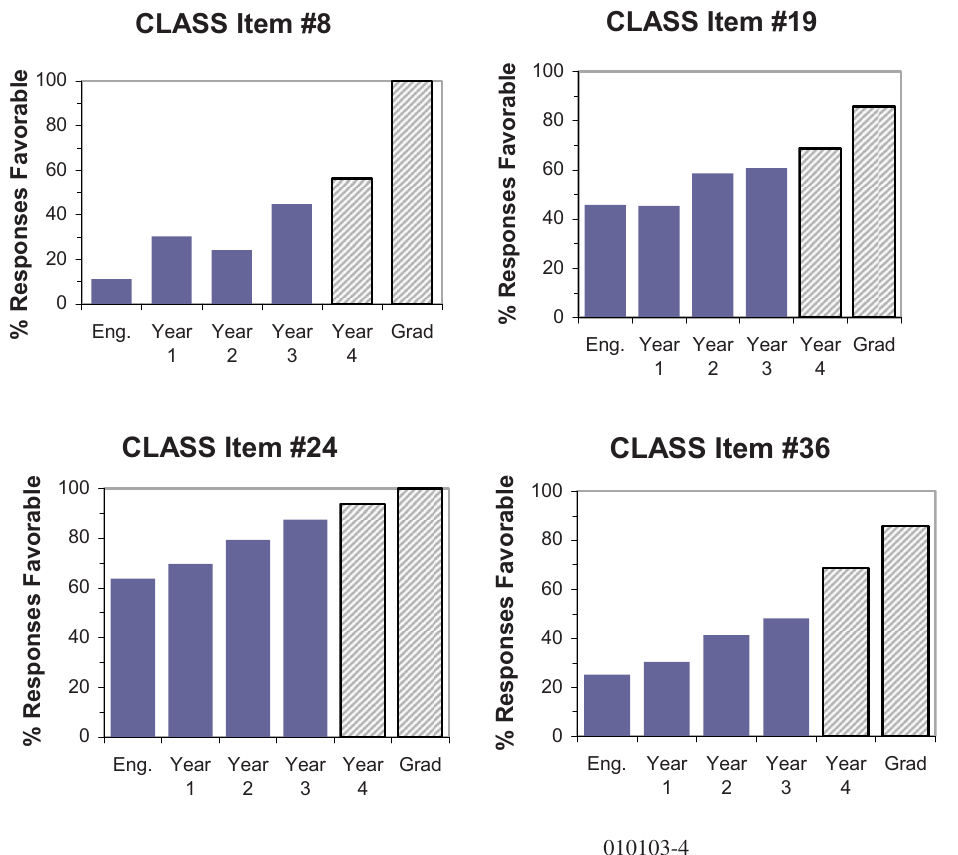
FIG. 3. (cid:1) Color (cid:2) Distributions of favorable responses for selected survey